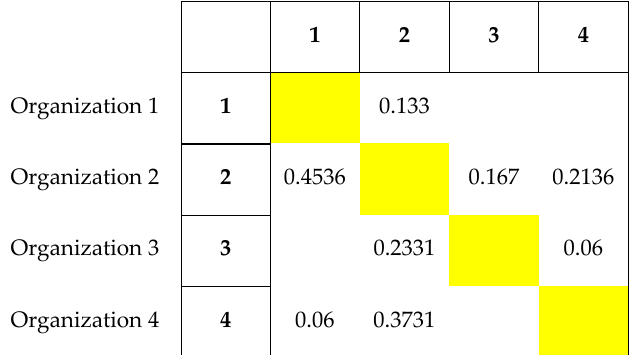
Figure 7. Matrix R showing the correlation between interorganizational workflows.